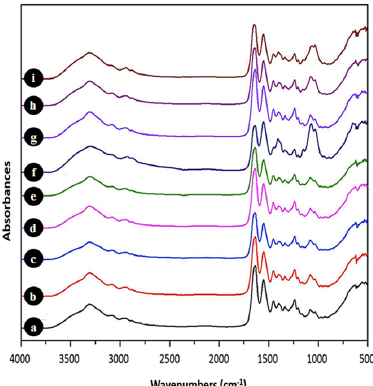
Figure 1. Protein composition of chitosan-coated collagen membranes. Following chitosan-coated collagen designed under various conditions, the produced membranes were subjected to Fourier transform infrared (FTIR) analyses. Spectra were obtained and plotted: ( a ) Unmodified collagen membrane, extensively washed (W); ( b ) 0.1% chitosan-coated collagen membrane, extensively W and non-crosslinked; ( c ) 1% chitosan-coated collagen membrane, non-W and non-crosslinked; ( d ) 0.1% chitosan-coated collagen membrane, crosslinked with glutaraldehyde (G) vapor and W; ( e ) 0.1% chitosan-coated collagen membrane, crosslinked with G vapor and non-W; ( f ) 1% chitosan-coated collagen membrane, non-W; ( g ) 1% chitosan-coated collagen membrane, extensively W; ( h ) 1% chitosan-coated collagen membrane, crosslinked with G and W; and ( i ) 1% chitosan-coated collagen membrane, crosslinked with G and non-W.